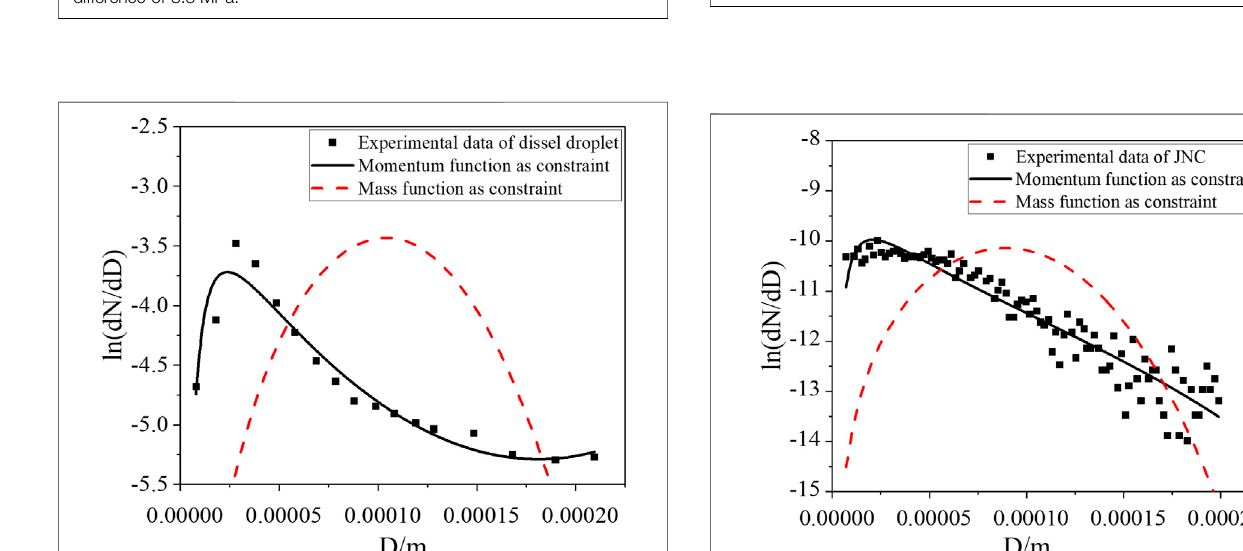
FIGURE 4 | Results of diesel droplet size distribution under the pressure difference of 8.8 MPa.